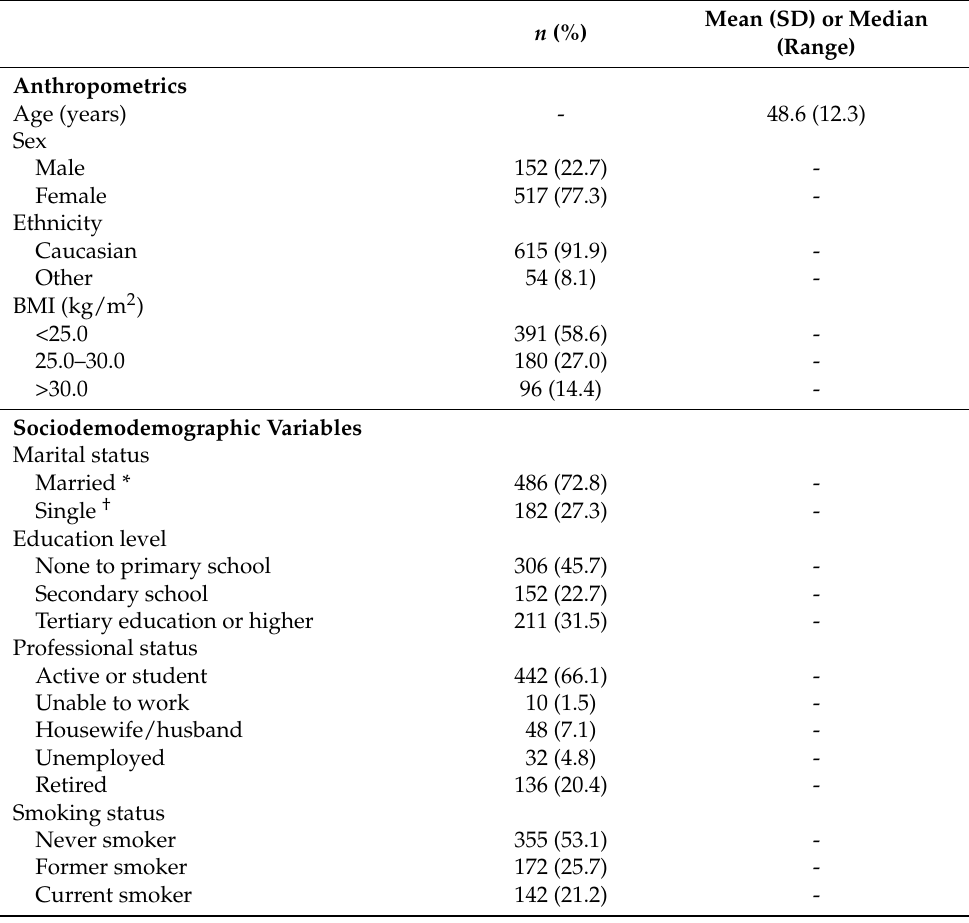
Table 1. Demographic and disease characteristics of patients with early rheumatoid arthritis (RA) from the ESPOIR cohort ( n =